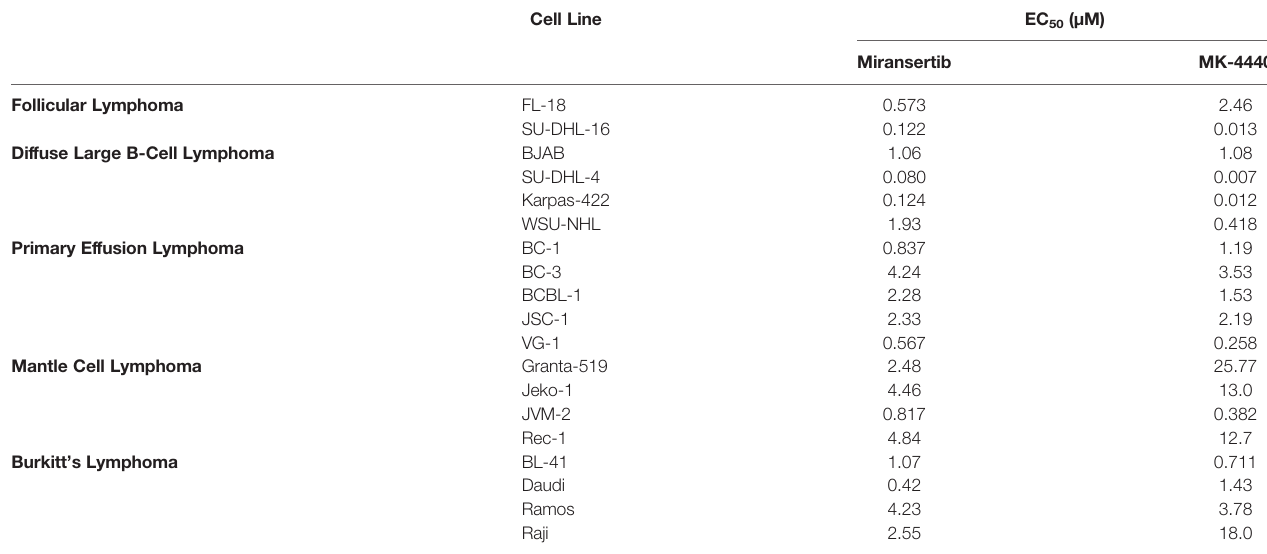
TABLE 1 | Summary of EC 50 for miransertib and MK-4440 calculated in a variety of NHL cell lines.